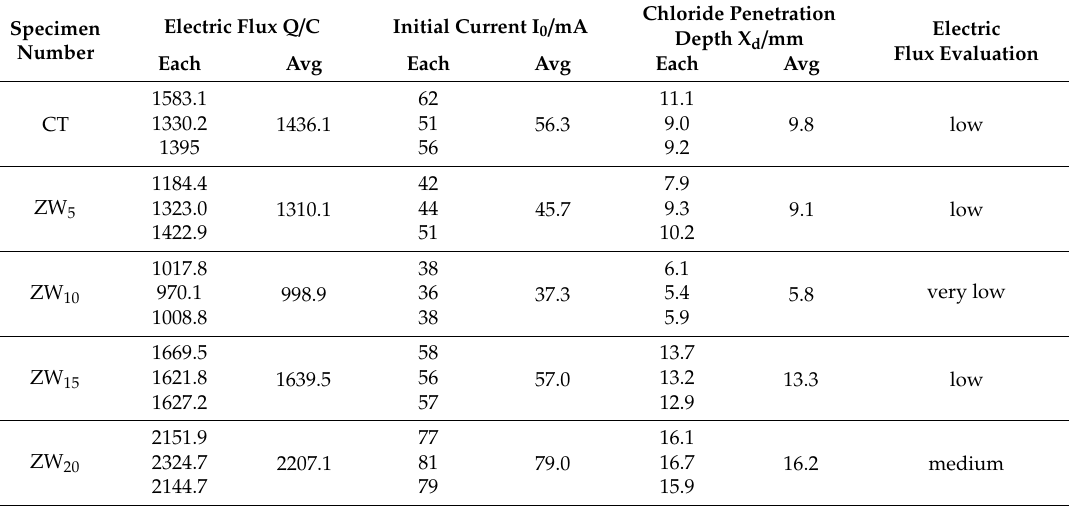
Table 8. Six h electric flux value, initial current value and chloride penetration depth value of concrete with different content of CANCP.